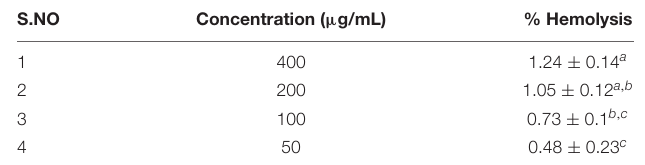
TABLE 5 | % Hemolytic analysis of A. pubiflora synthesized